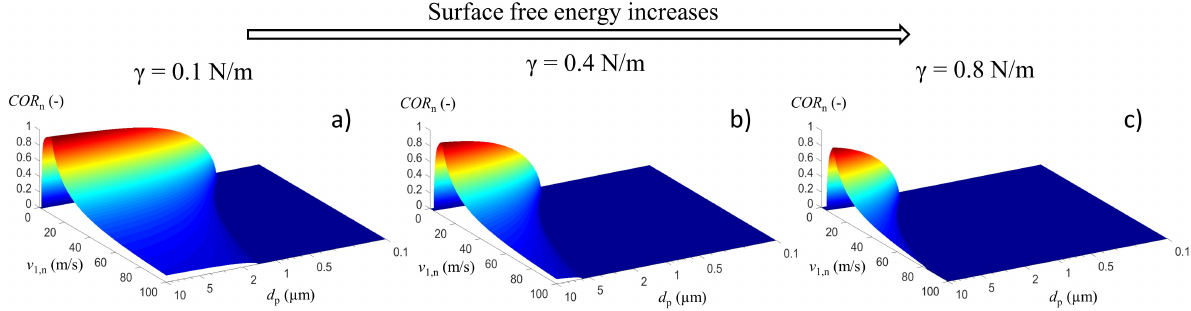
Figure 6. Surface plot of COR n calculated according to the Ohio State University (OSU) model [31] for a fixed value of the wall shear velocity, equal to 15 m/s. The charts refer to: ( a ) γ = 0.1; ( b ) γ = 0.4; and ( c ) γ =